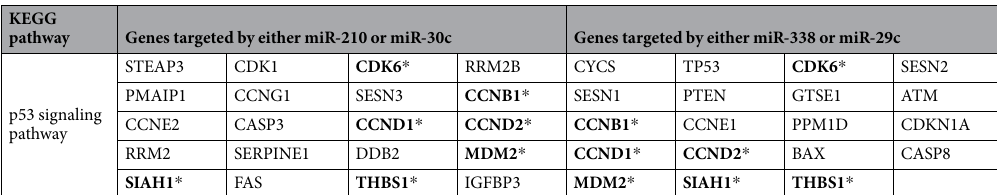
Table 5. Genes targeted by significant miRNA pairs in p53 signaling pathway. * Bold genes represent the common genes targeted by both two significant miRNA